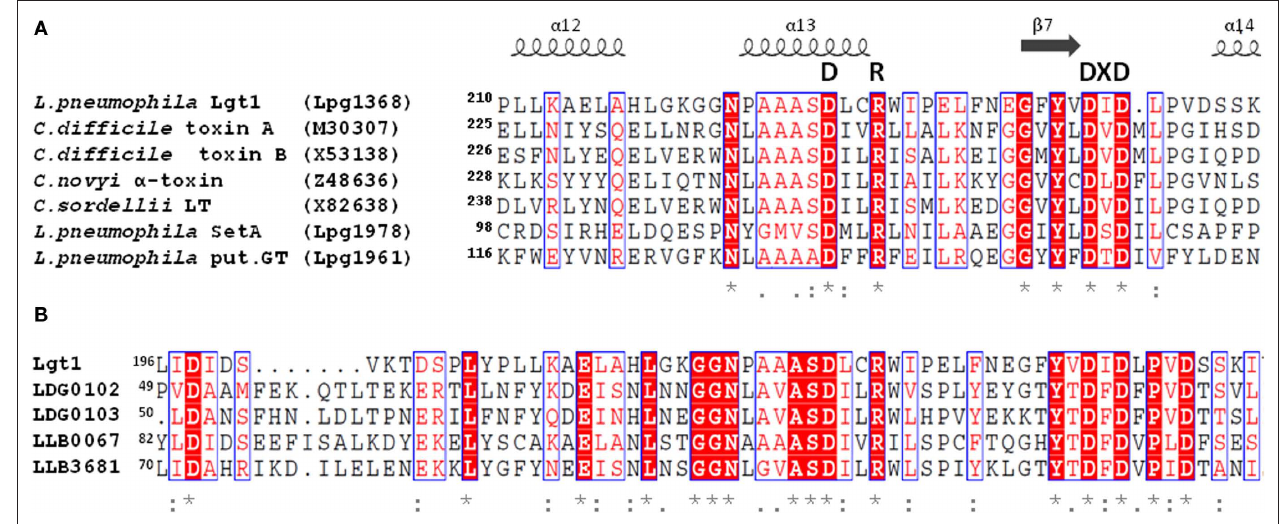
FigurE 1 | (A) Alignment of partial amino acid sequences of Lgt1, SetA, Lpg1961 from L. pneumophila Philadelphia-1 strain with that of proteins from a clostridial glucosylating toxin family: Toxins A and B from C. difficile , α -toxin from C. novyi , and lethal toxin from C. sordellii . Gene bank accession numbers